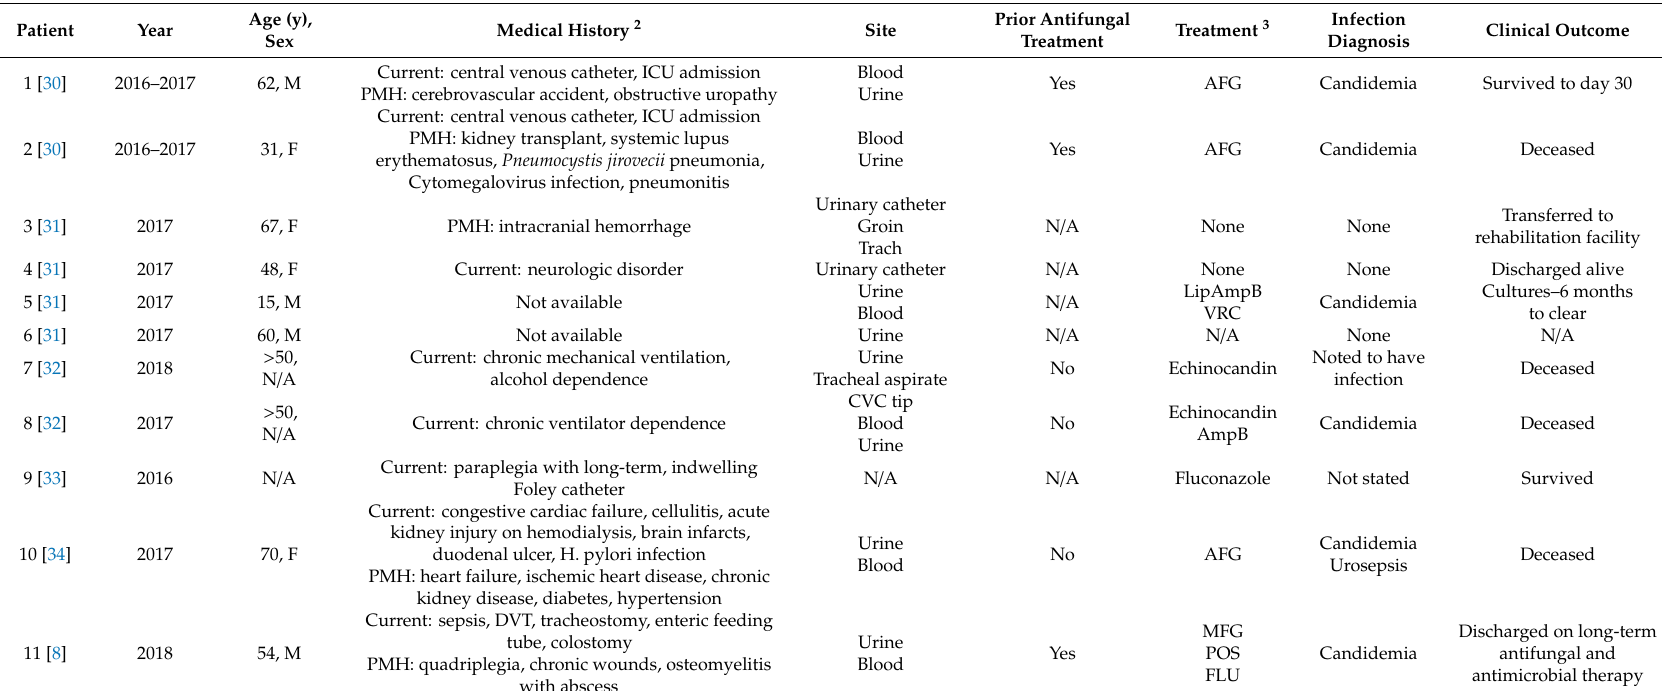
Table 1. Review of published reports of Candia auris isolates in urine 1